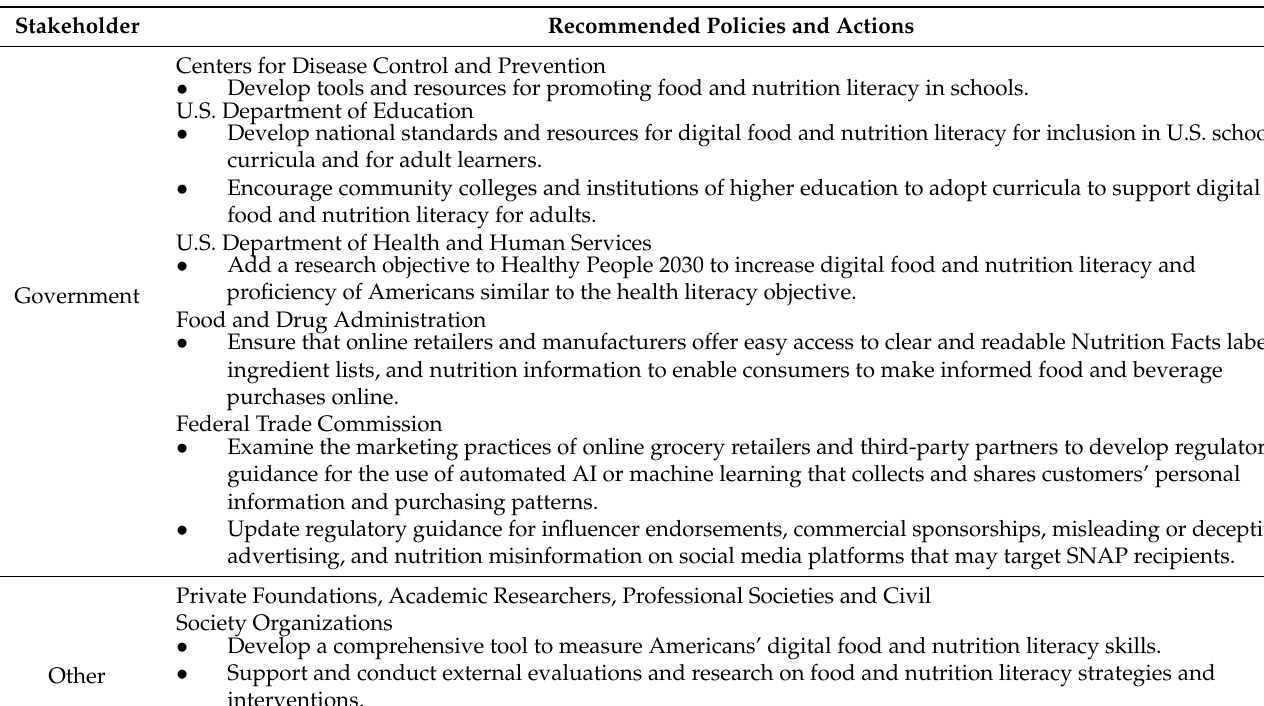
Table 4. Recommended policies and actions for U.S. government agencies and other stakeholders to improve the policies, systems, and environments that support Americans’ digital food and nutrition literacy, access and safety. Stakeholder